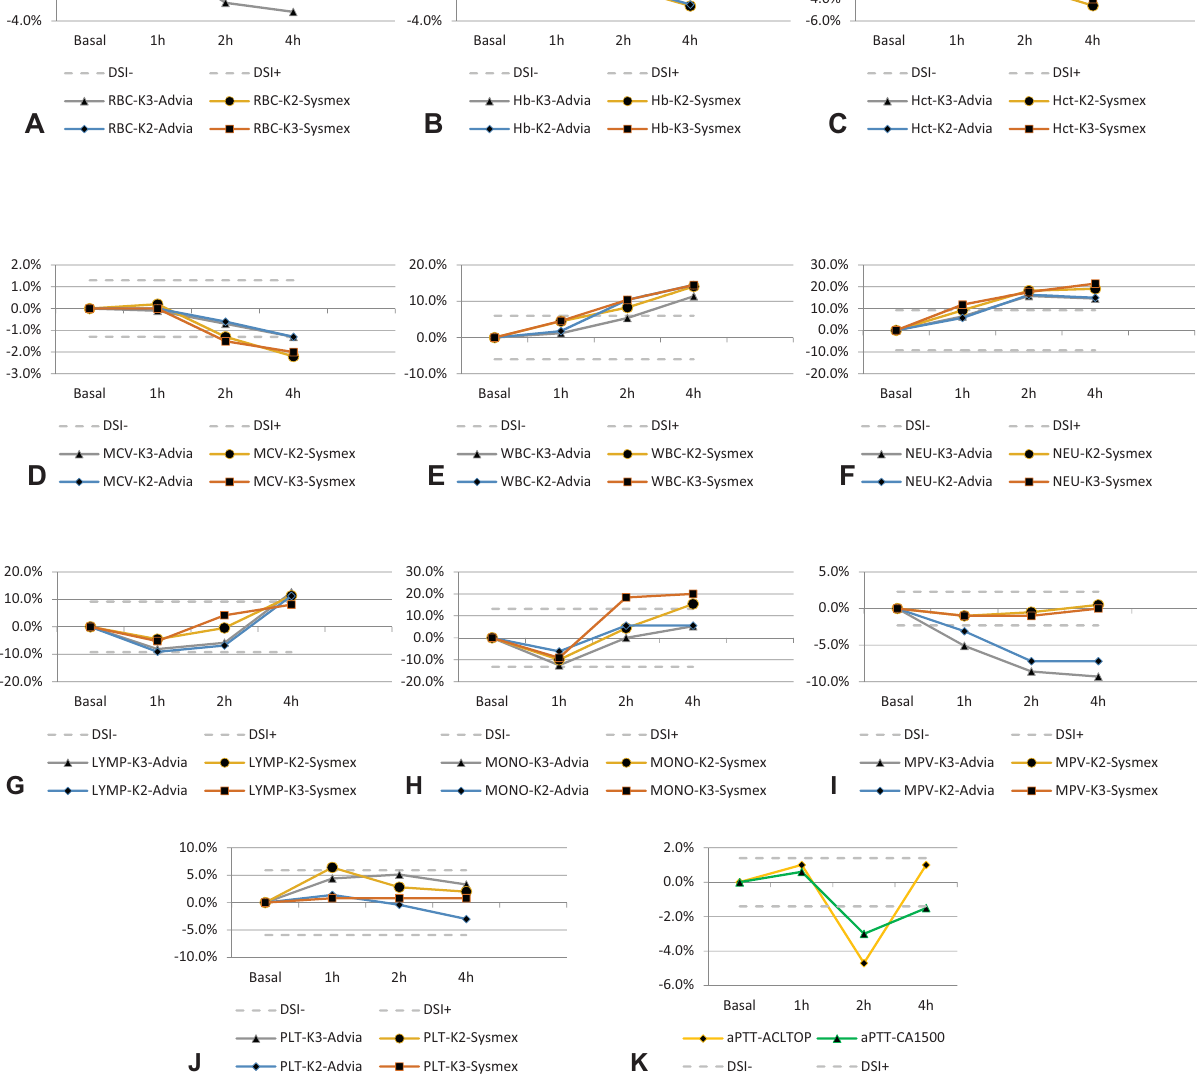
Fig. 1 Interferograms. ( A ) red blood cell (RBC); ( B ) hemoglobin (Hb); ( C ) hematocrit (Hct); ( D ) mean corpuscular volume (MCV); ( E ) white blood cell (WBC); ( F ) neutrophil (NEU); ( G ) lymphocyte (LYMP); ( H ) monocyte (MONO); ( I ) mean platelet volume (MPV); ( J ) platelet (PLT); and ( K ) activated partial thromboplastin time (aPTT). Hours after the breakfast ( x -axis) are plotted against bias values ( y -axis). Solid line, bias. Dashed lines, acceptable criteria based on desirable speci fi cation for imprecision (DSI) derived from biologic